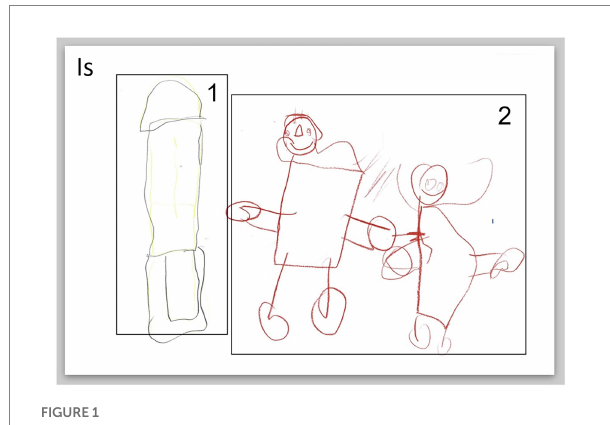
Figure 1. All excerpts are translated from German or the Swiss German dialect preserving the statement’s original character. Gestures and further information are included in parentheses. The letters indicate the child, the numbers the paragraph in the transcript.